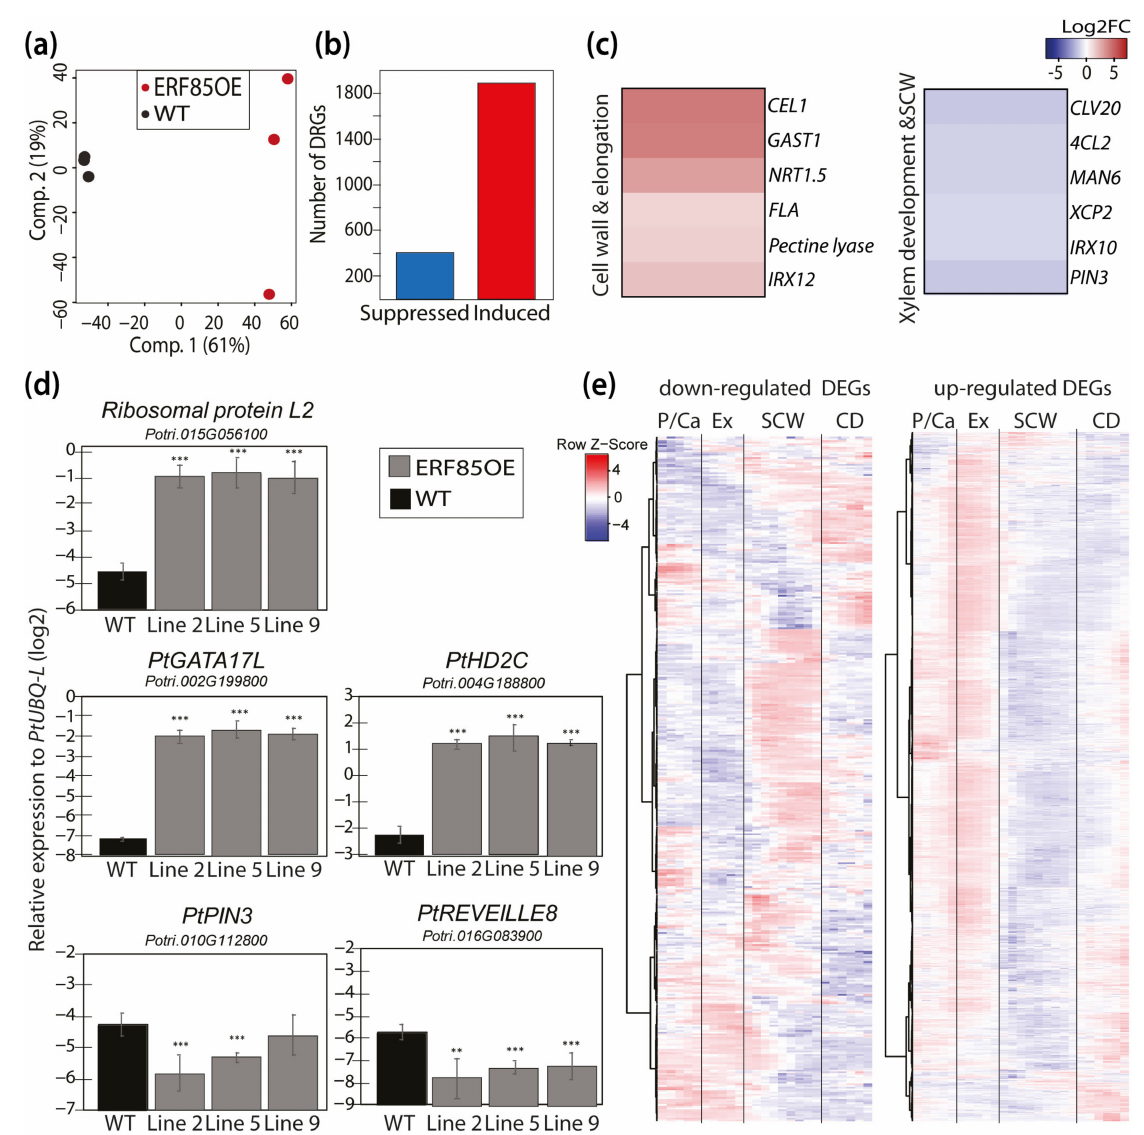
Figure 4. Ectopic expression of PtERF85 stimulated the expression of genes linked to cell expansion and suppressed genes linked to SCW formation during xylem differentiation. ( a ) PCA of xylem transcriptome data obtained from three WT samples (WT, each sample represents a pool of three plants) and three ERF85OE lines (2,5,9). ( b ) Distribution of (DEGs in ERF85OE. DEGs were selected based on a |log2FC| > 1 and pAdj < 0.01 compared to WT. ( c ) Representative genes found among the DEGs in ERF85OE lines with known function of their homologs in Arabidopsis related to cell elongation, cell wall composition, and xylem development ( Potri.015G127900 (CEL1); Potri.002G022600 (GAST1); Potri.001G171900 (Pectate lyase); Potri.008G064000 (IRX12); Potri.014G156600 (CLV20); Potri.010G112800 (PIN3); Potri.005G256000 (XCP2)) and SCW composition (Potri.010G192300 (FLA); Potri.001G036900 (4CL2); Potri.016G138600 (MAN6); Potri.005G256000 (IRX10)), Potri.003G088800 (NRT1.5 ). ( d ) Validation of differential expression of up- and down-regulated DEGs using qPCR.